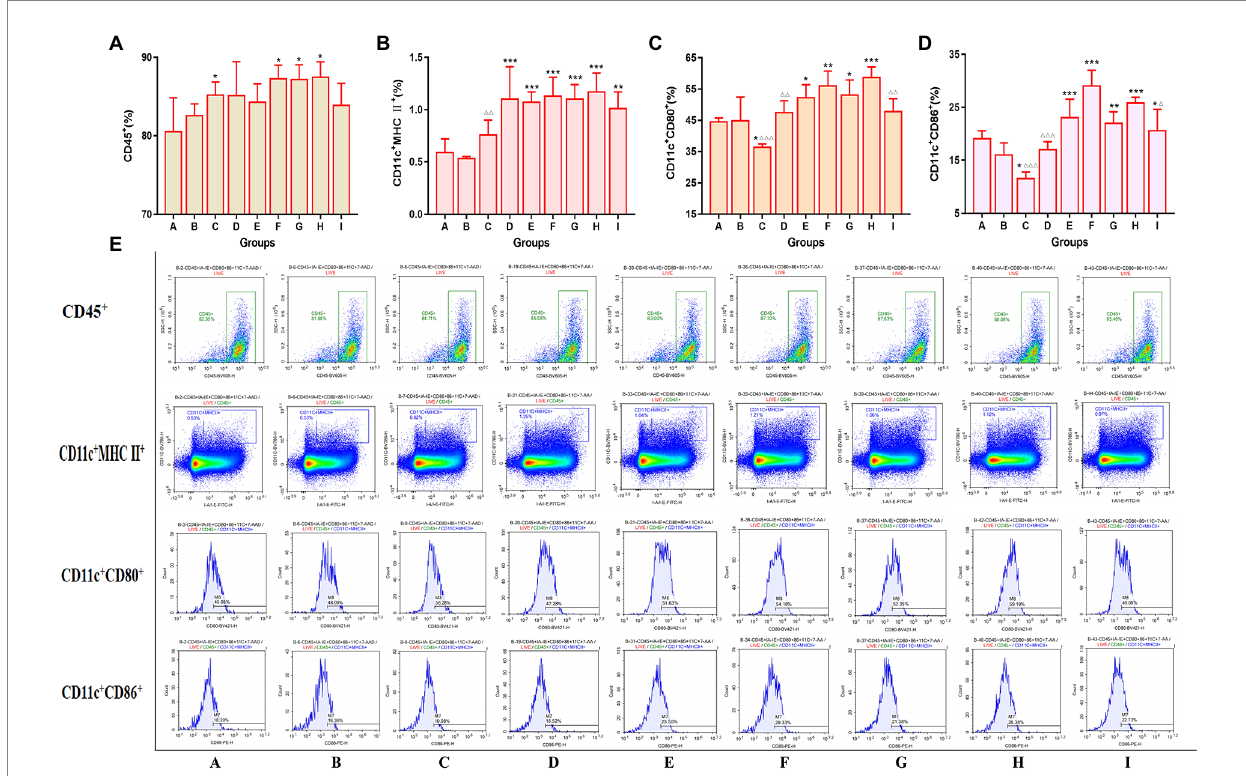
FIGURE 7 Changes in the expression of bone marrow co-stimulatory signaling molecules across the indicated groups as detected by flow cytometry. (A) CD45 + ; (B) CD11c + MHC II + ; (C) CD11c + CD80 + ; (D) CD11c + CD86 + ; (E) representative flow cytometry plots of each detected co-stimulatory signaling molecules. Significant differences were defined between the influenza vaccination alone group and other vaccination groups (* p < 0.05, ** p < 0.01, *** p < 0.001), and between the influenza vaccine and Astragali Radix co-immunized group and other TCM-adjuvant groups ( △ p < 0.05, △△ p < 0.01, △△△ p <